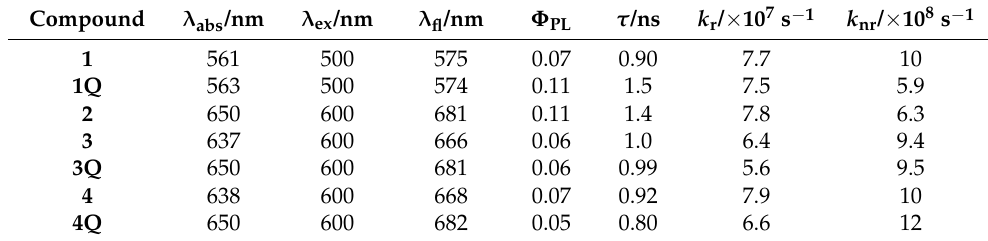
Table 1. Optical parameters for SubPcs dichloromethane